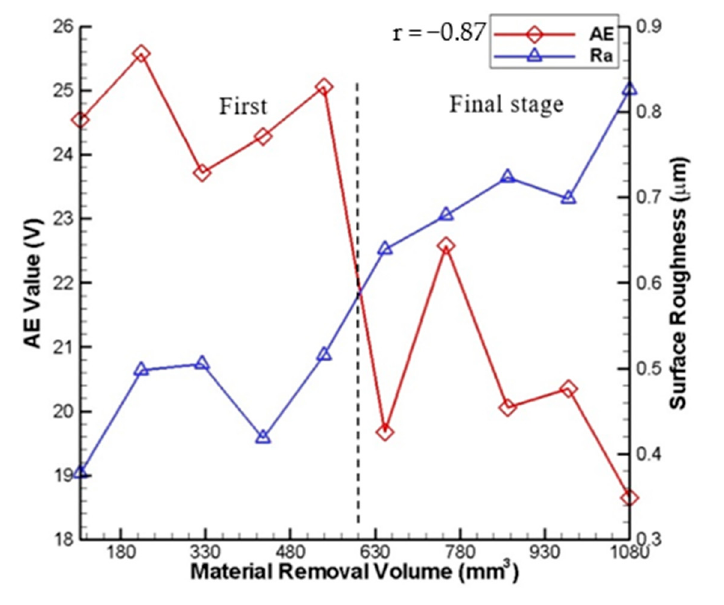
Figure 10. Comparison of measured AE signals and measured surface roughness with material removal volume.